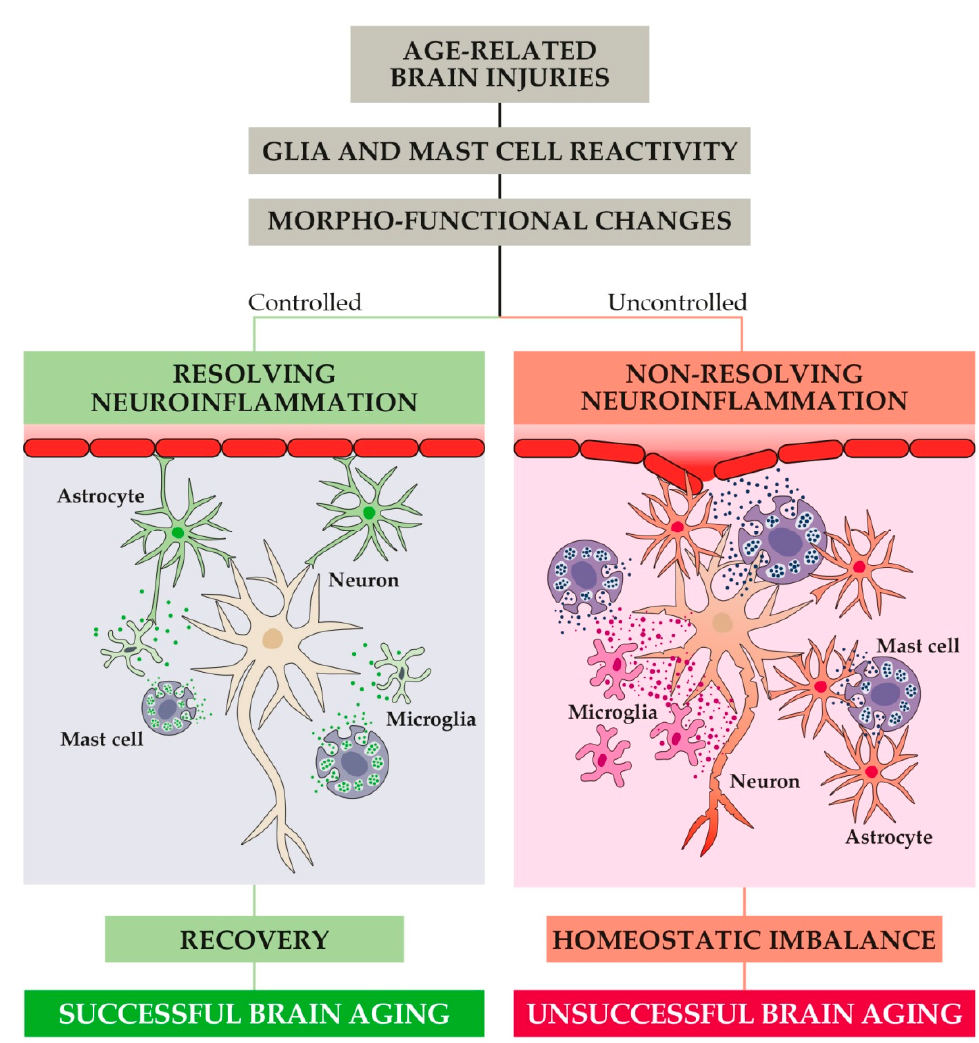
Figure 4. In response to age-related brain injuries, CNS immune cells (i.e., astrocytes, microglia, and mast cells) become activated and undergo profound morpho-functional changes toward a reactive phenotype. If the resulting release of pro-inflammatory mediators is not properly controlled, non-resolving neuroinflammation may begin. Under this condition, progressive dysfunction at the synaptic and neurovascular level occurs and ultimately leads to homeostatic imbalance and unsuccessful brain aging (i.e., impairments of cognitive and behavioral